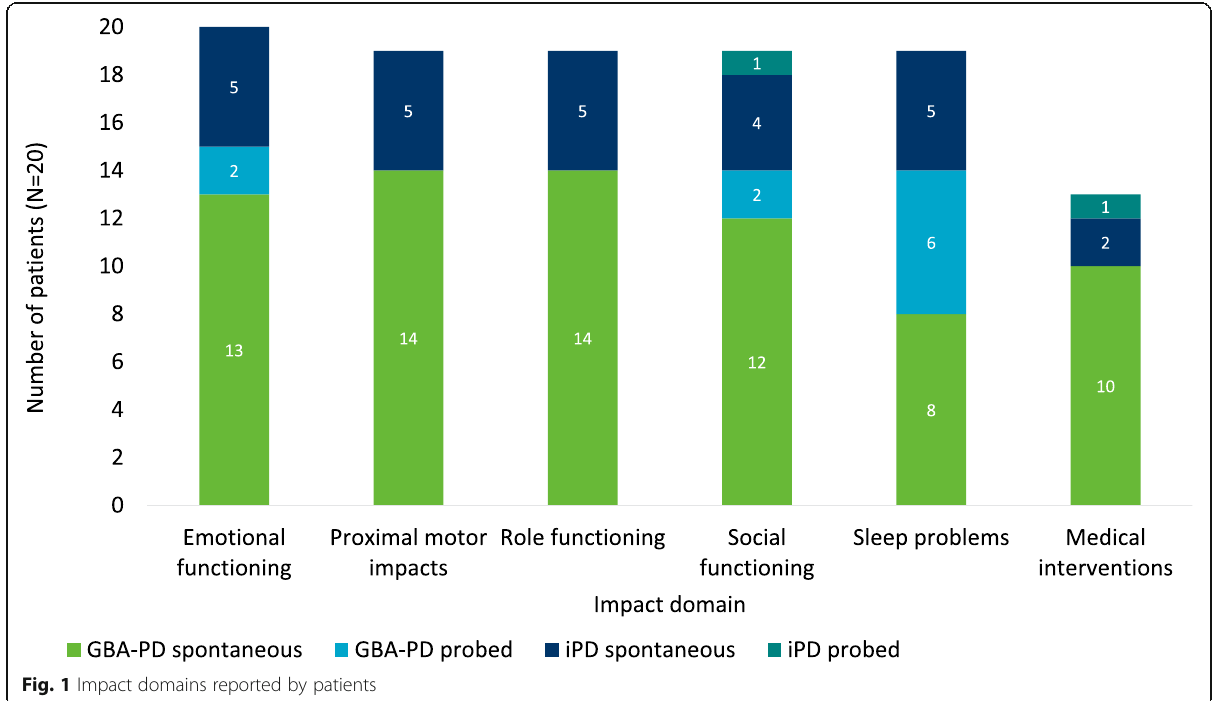
Fig. 1 Impact domains reported by